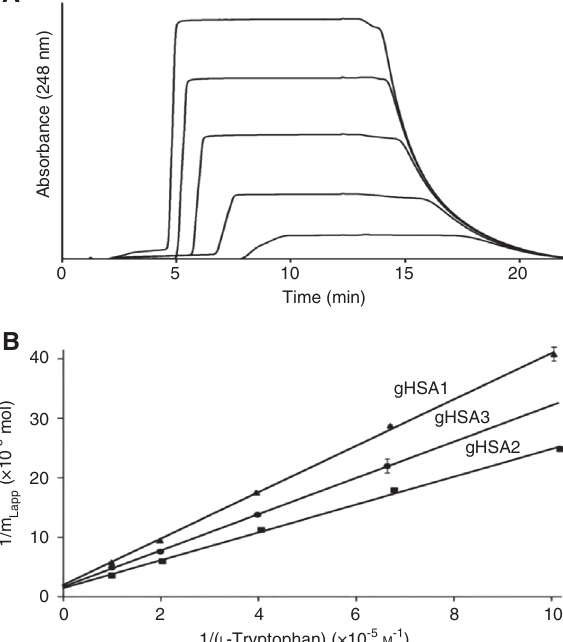
Figure 7 (A) Typical results for a frontal analysis experiment involv- ing the application of acetohexamide to an HPAC column containing normal HSA using a 2.0 cm × 2.1 mm i.d. column at 0.5 mL/min and (B) examples of double-reciprocal plots that were generated accord- ing to Equation (2) for the binding of L-tryptophan to HPAC columns that contained three different types of in vitro glycated HSA.